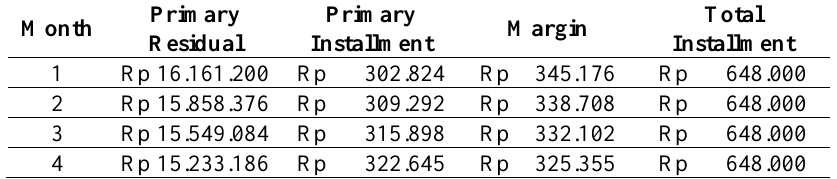
Table 3 Payment Installments of a Two Wheeled Motor Vehicle With the al-Murabahah